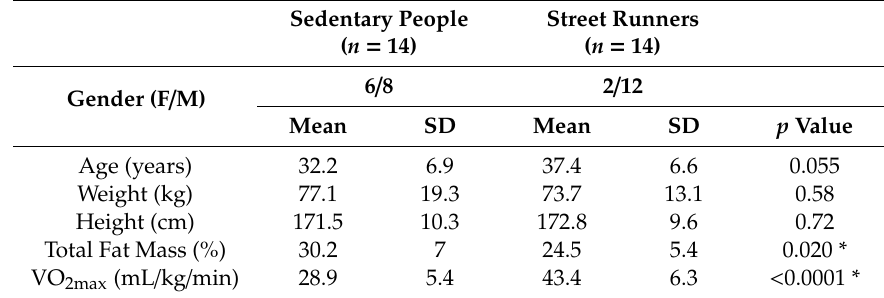
Table 2. Anthropometric and aerobic capacity characteristics of both sedentary and running groups.